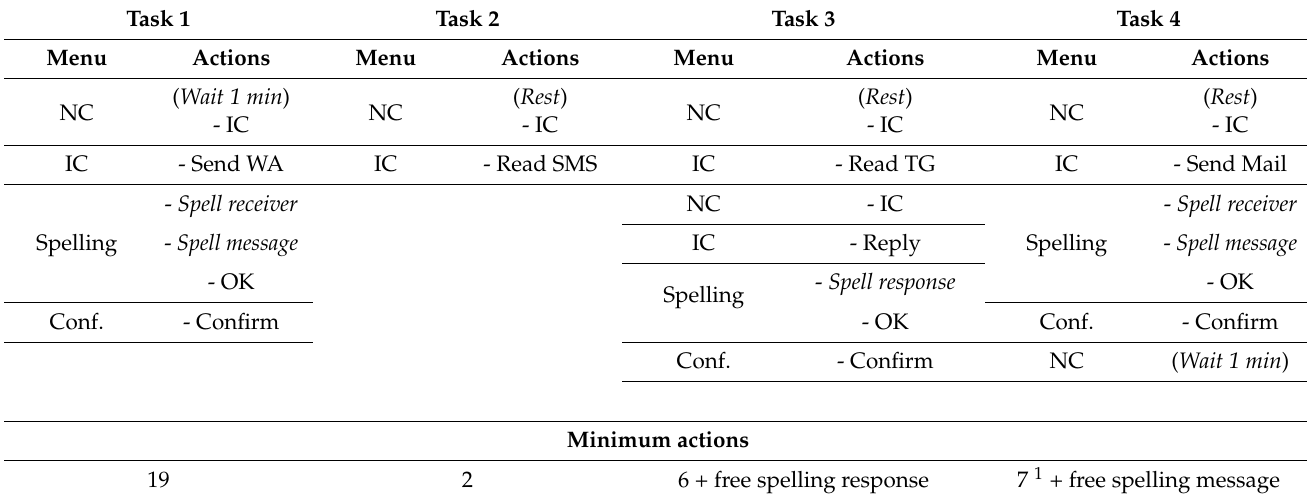
Table 2. For each task (column), the actions required to complete the task are detailed (right sub-column) as well as the menu in which they should be performed (left sub-column). The normal text corresponds to specific command selection actions (e.g., IC or Send WA); italics correspond to grouped actions (e.g., Spell receiver ) or to more general instructions (e.g., Rest